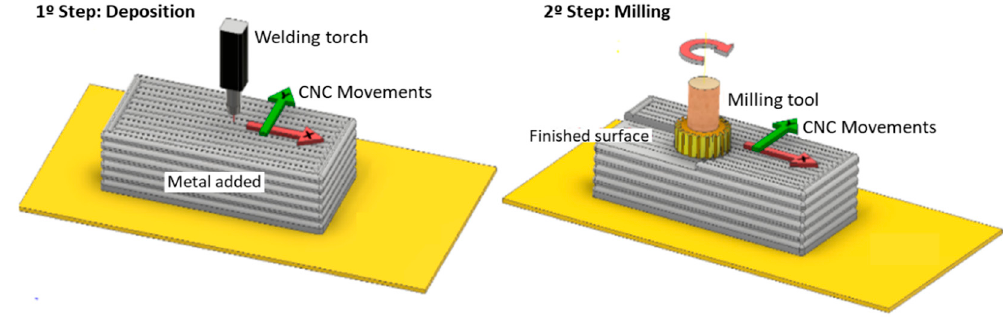
Figure 29. Steps in the hybrid process of metal additive manufacturing combining WAAM and milling (adapted from [138]).